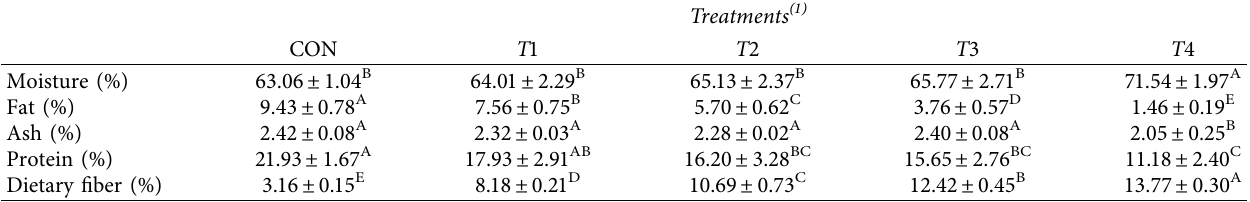
Table 2: Chemical composition of the hybrid beef patty with shiitake mushroom ( Lentinus edodes